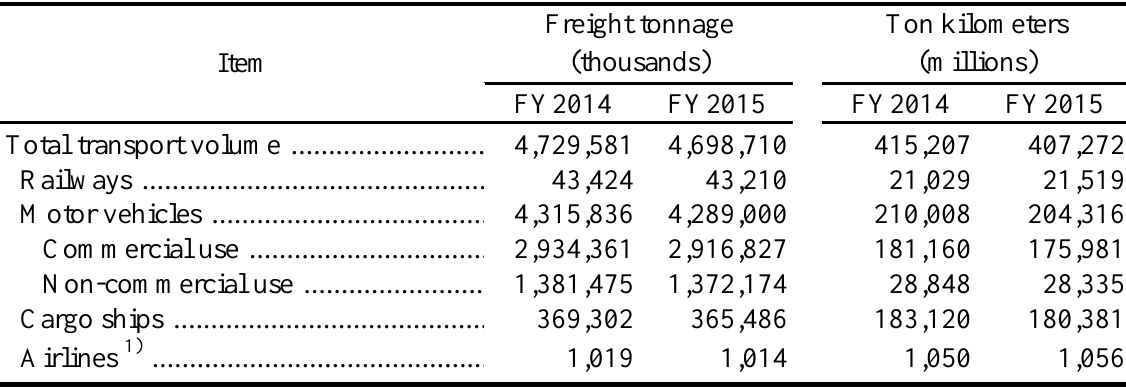
Domestic Freight